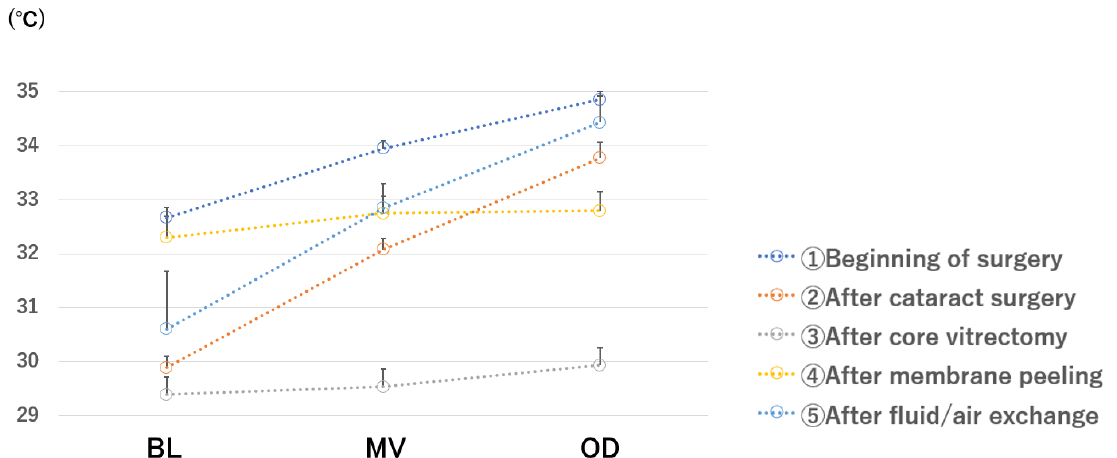
Figure 1. Intraocular temperature distribution at the beginning of surgery. There was a significant difference in the temperature between any two of the four sites. The temperature was lowest in the anterior part of the eye, and it gradually increased at sites closer to the posterior retina. Thus, there was a gradient with higher temperatures toward the posterior of the eye. The upper end of the whisker is the maximum value, and the lower end is the minimum value. The box indicates the interquartile range; the horizontal line in the box indicates the median value, and the × indicates the mean. AC, anterior chamber; BL, just posterior to the crystalline lens or intraocular lens; MV, mid- vitreous; OD, just anterior to the optic disc. **: p < 0.01. The local temperatures at several intraocular sites are shown in Figure 2. The tem- perature gradient was present at the beginning, and it became flatter after cataract sur- gery. After core vitrectomy, a gradient was not present. A steeper gradient was detected after membrane peeling, and a gradient was present after fluid/air exchange.